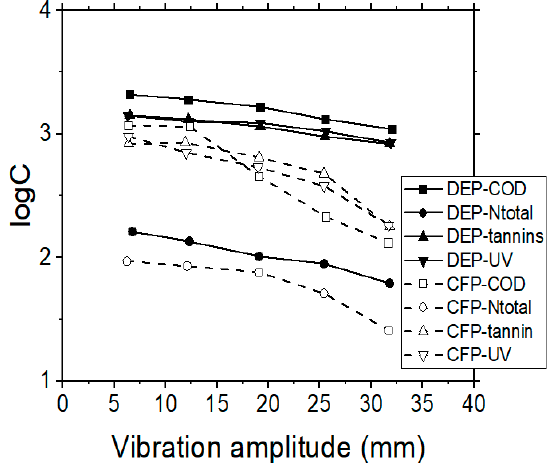
Figure 2. Effect of vibration amplitude on COD, N total , ultraviolet (UV) 254 nm and tannins concentrations, when performing MF membrane experiments, during dead-end (DEP) or cross-flow (CFP) operating modes.